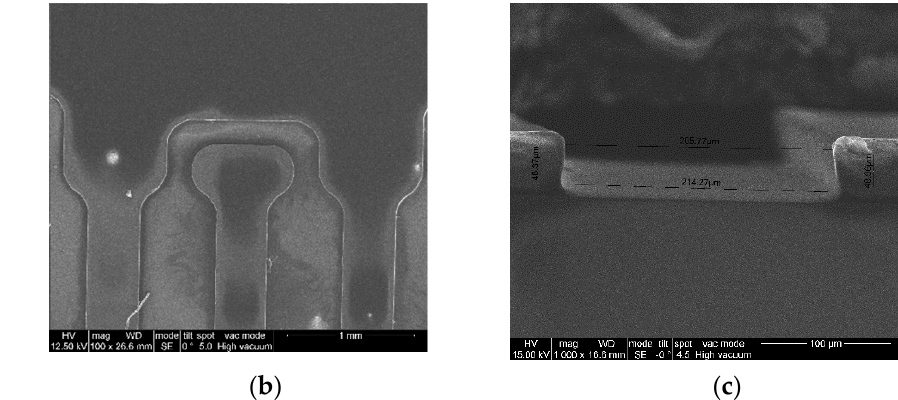
10 of 20 Figure 6. Images of microfluidic systems formed using SU-8 photoresist: ( a )—general view of the microfluidic system, ( b )—SEM-image of the detection zone section, ( c )—SEM-image of the micro- fluidic channel chip. The profiles of microfluidic channels generated with SU-8 photoresist demonstrate the geometry perfectly matching the photomask (Figure 6b) and the 3D structure with